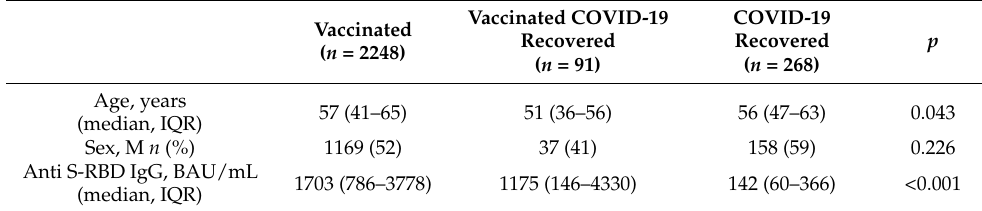
Table 1. Demographic characteristics and anti S-RBD IgG levels in the three groups was investigated.